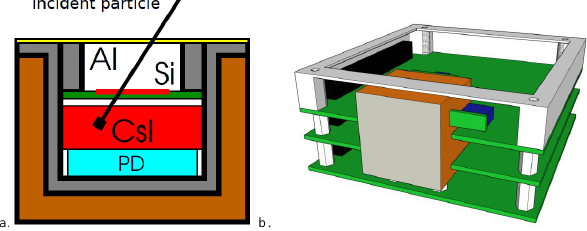
Figure 3. a) A cut of the RADMON detector unit showing the Si detector (blue chip) and the CsI(Tl) scintillator (red cube). Particles enter the system through the 300-µm thick Al window (grey) and a signal from both detectors is required for counting the particle. The housing (brown) is made of brass. b) Sketch of the RADMON unit including the stack of three PCBs (analogue, digital and power supply, from top to down) and the detector unit in the front (grey, brown box) .